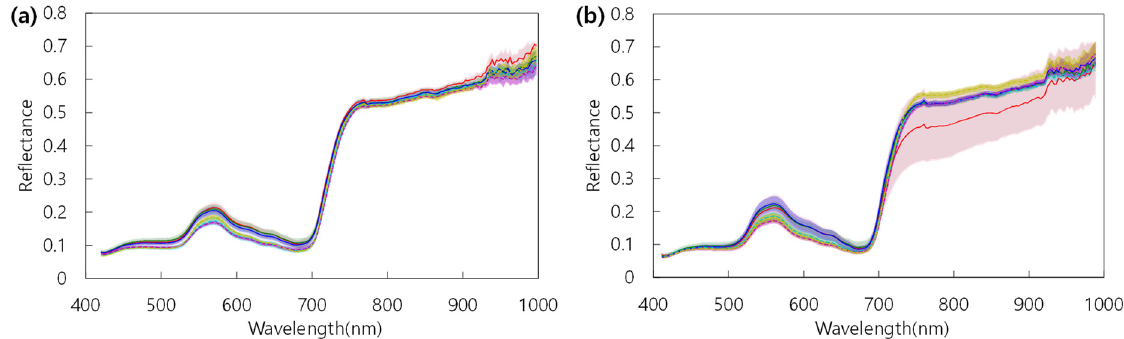
Figure 3. Differences in reflectance by fertilization level in the flag leaf ( a ) and the 2nd uppermost leaf ( b ) at the heading stage. Yellow: N1, magenta: N2, cyan: N3, blue: N4, green: N5, red: N6.